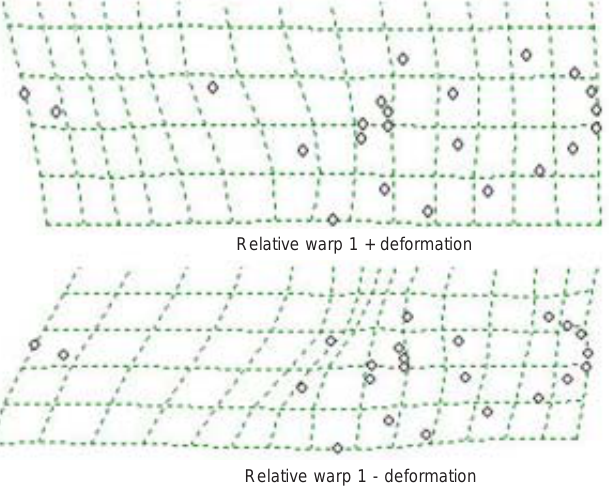
Figure 9. Plots of first two relative warps (based on Alpha = o) shown both as Thin – plate spline for positive and negative displacements along the first relative warp axes showing the net arrangement of land marks. (Alpha = 0)